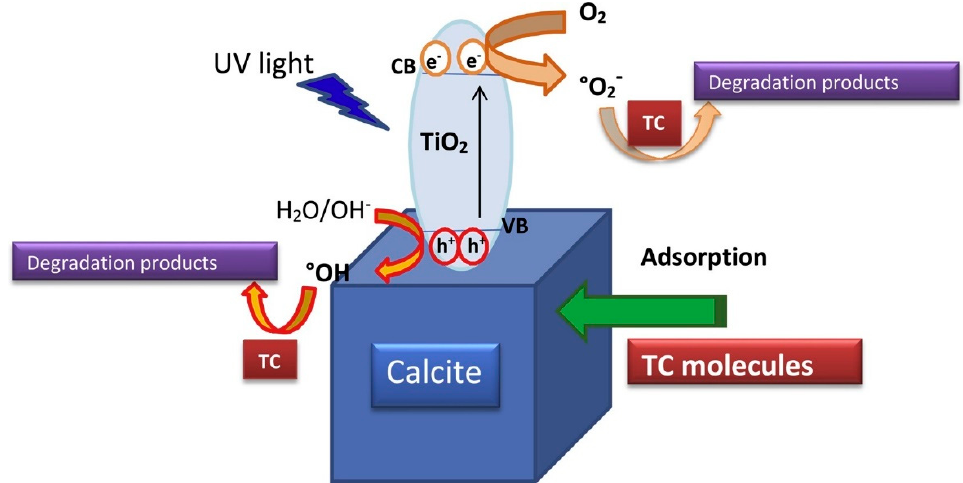
Figure 4. Representation of the photocatalytic process of calcite-titania-TC system. Reprinted from Belhouchet et al. [67] Copyright (2019), with permission from Elsevier.